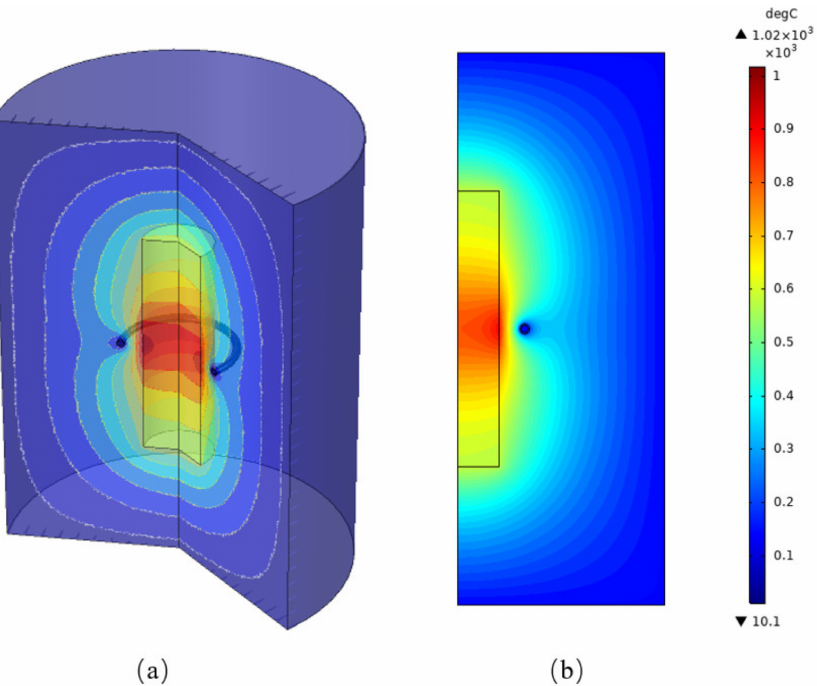
Figure 5. The temperature profile of the zone melting reactor. ( a ) 3D; ( b )